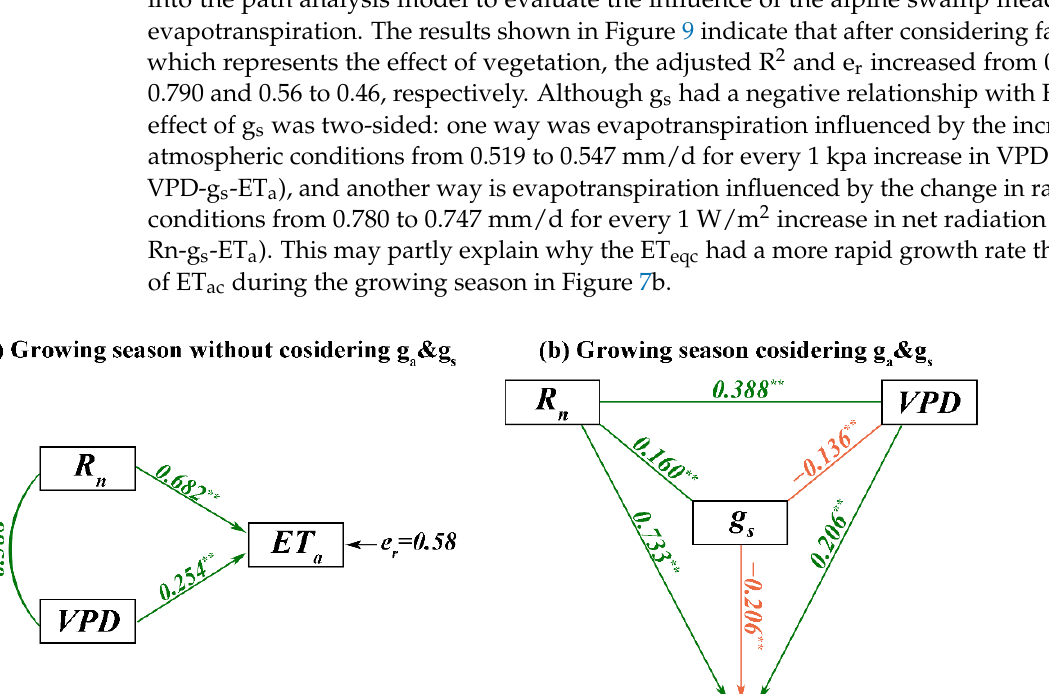
Figure 10. The process of evapotranspiration at the alpine swamp meadow; the bottom half refers to the VSWC and ST; ST and VSWC are denoted by contours and color strips, respectively. The upper half shows the condition of the underlying surface. The arrow implies evapotranspiration from the surface and the dark blue underlying surface represents the exposed water.